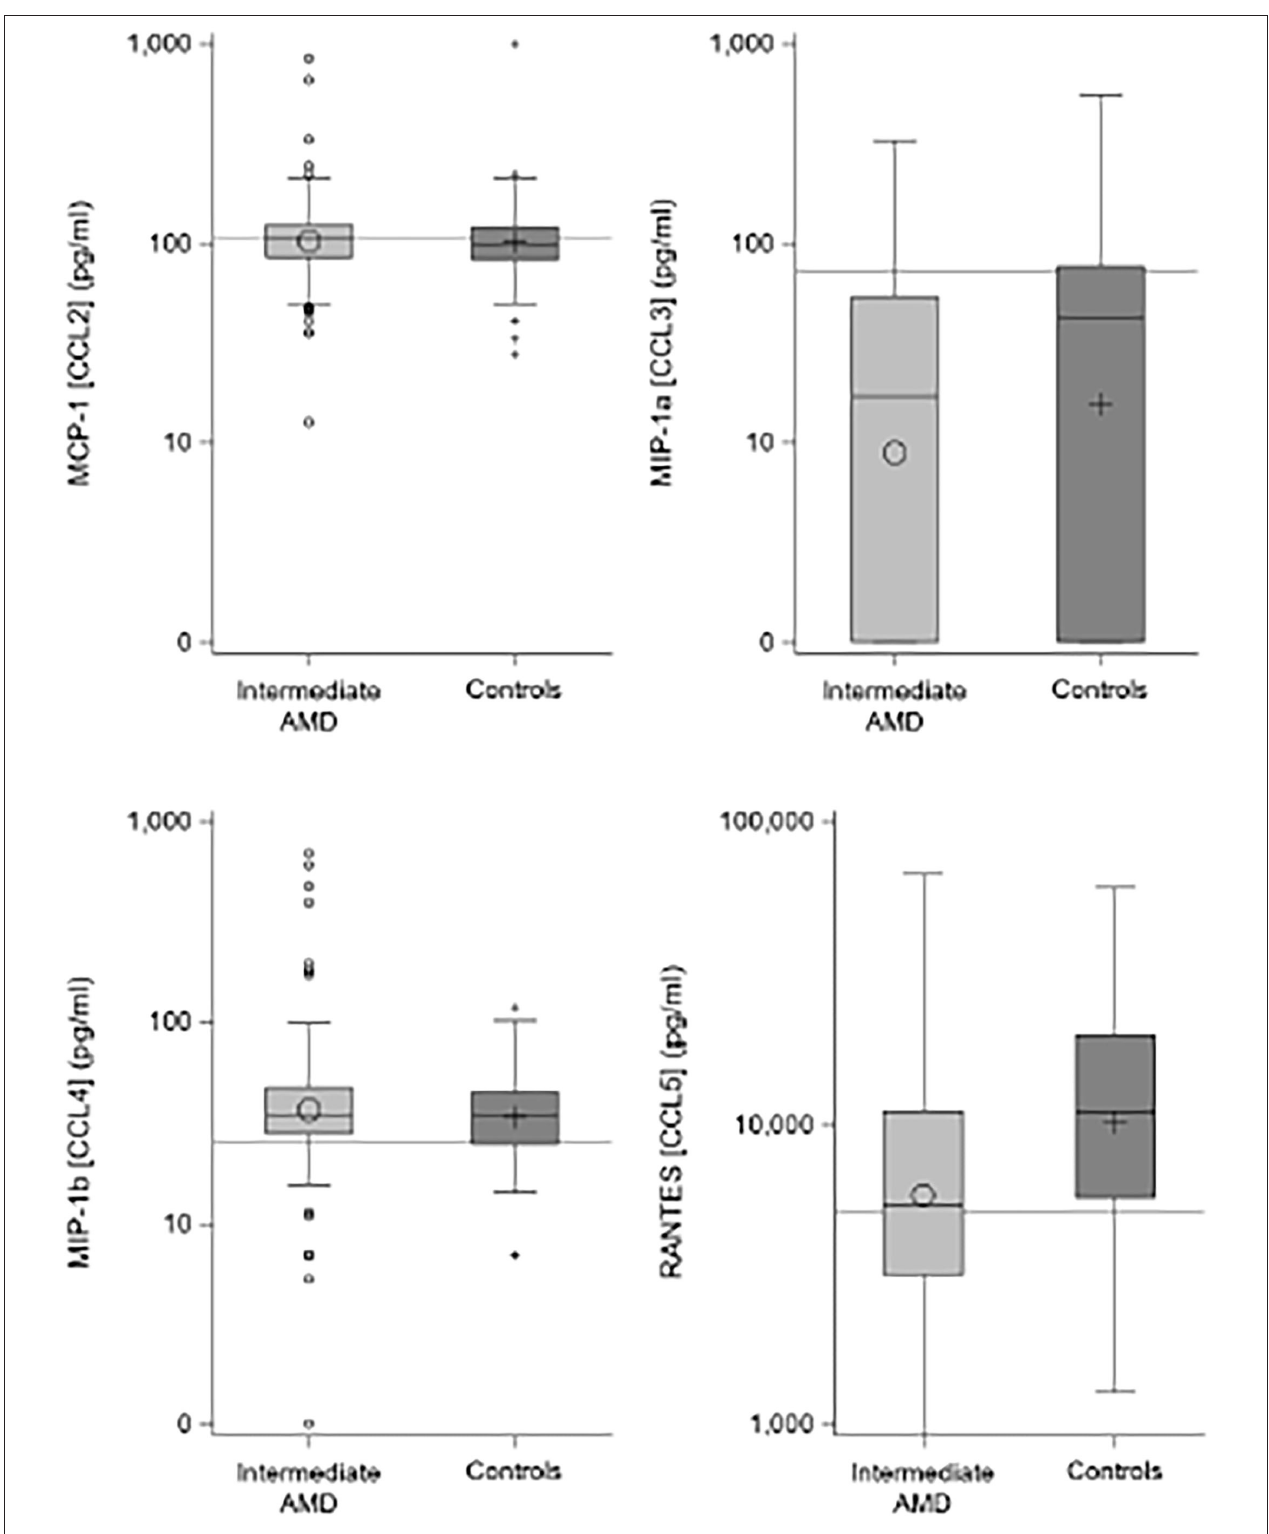
FIGURE 1 | Boxplots comparing chemokine levels between iAMD and controls. Horizontal lines are the cutoff values from Table 3 .